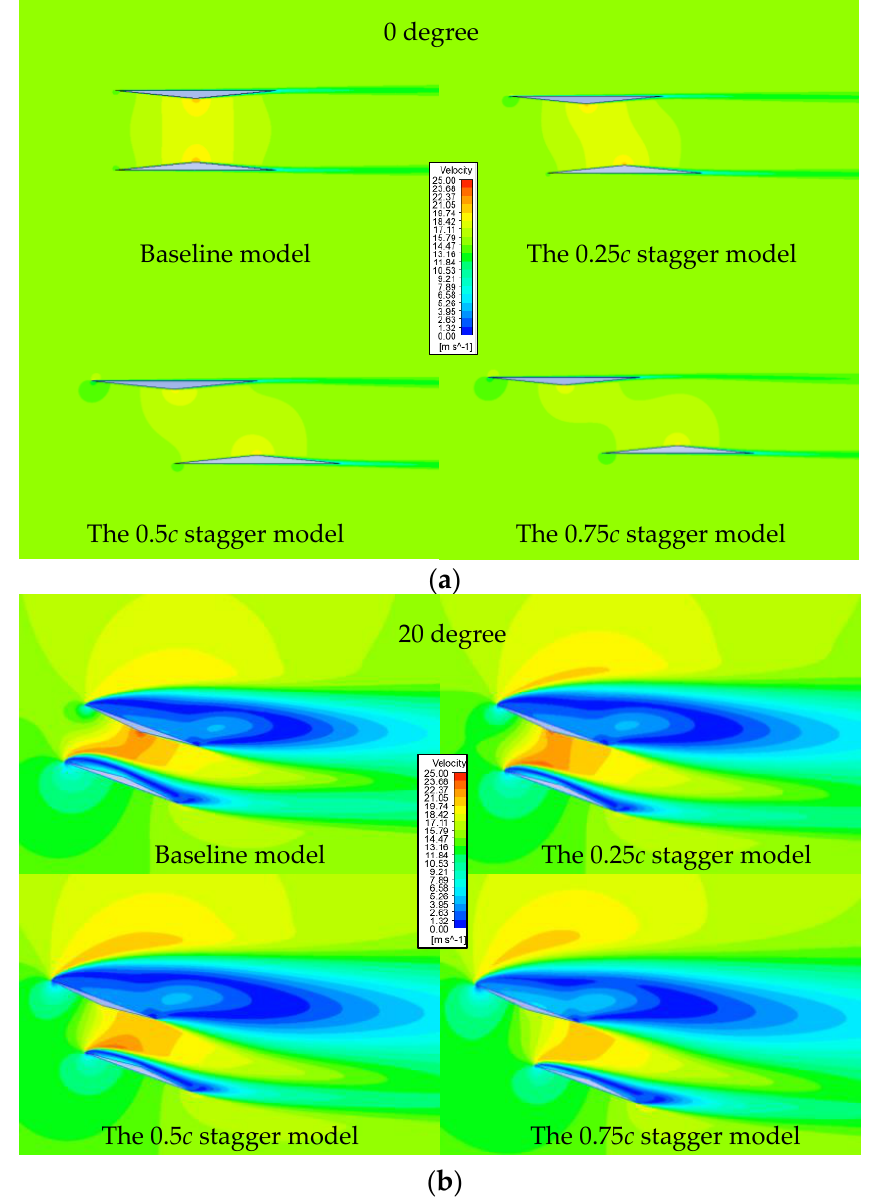
Figure 12. Velocity distributions around the staggered biplane configuration (CFD results): ( a ) 0 degrees; ( b ) 20 degrees.